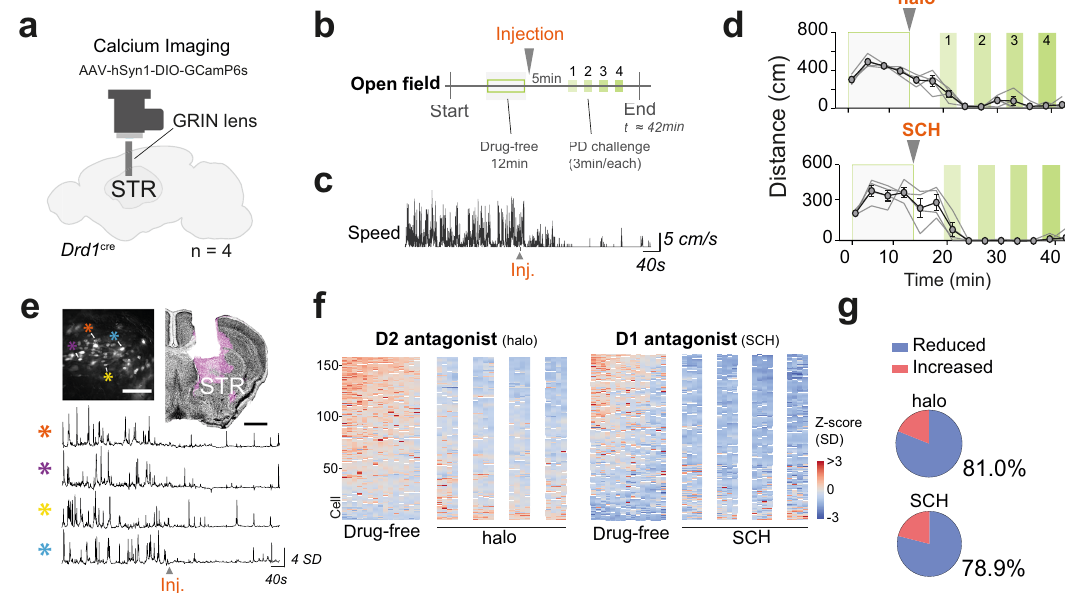
Fig. 4 D1 and D2 receptor antagonists reduce the striatal activity of D1-MSNs. a Miniaturized microscope positioned over the dorsal striatum (STR) of Drd1 cre mice ( n = 4) with local injection of AAV carrying Cre-dependent GCamP6s. b Experimental paradigm. c Example trace showing instantaneous speed pro fi le of an animal injected with haloperidol. d Behavioral quanti fi cation of distance moved (cm) throughout the test. Individuals are represented by thin lines while group mean ± SEM are in black. Background colors corresponding to recording periods presented in b . Reduction of distance moved upon drug injection accounts for 87.46% of the total variance (Two-way RM ANOVA, time F (13, 39) = 47.42 with p < 0.0001, both sessions analyzed in conjoint). e Left upper panel shows a fi eld of view (FOV) with neuronal units expressing GCamP6s (scale 100 µ m, image based on maximum deviation from average fl uorescence, with neurons that have large differences in intensity over time becoming brighter in this projection type). The upper right shows a coronal slice with lens position above the dorsal striatum for the same animal (scale 1 mm, 0.38 mm from bregma), GCamP6s expression stained in magenta (NeuroTrace in black). The lower panel shows calcium dynamic traces from four cells identi fi ed in the FOV (*) ( Z -score in units of SD). Experimental stages plotted as continuum and traces belong to haloperidol session speed pro fi le shown in c . f Calcium dynamics of striatal Drd1 neurons before and after haloperidol (left, 158 cells) or SCH (right, 166 cells). Heat map bins of 50 s. Reduction in signal upon drug injection (Spearman ’ s correlation: STR halo r = − 0.9582, STR SCH r = − 0.9542). g Pie charts show the fraction of all neurons that decreased (blue) or increased (red) their activity during PD state as s s compared to a drug-free period (for detailed analysis see Fig. S2d – g). Data are presented as Z -score in units of standard deviation (SD) from the baseline value, extracted from the 24 min recording. See also Fig. S2 and detailed stats in Table S2. Source data are provided as a Source Data fi